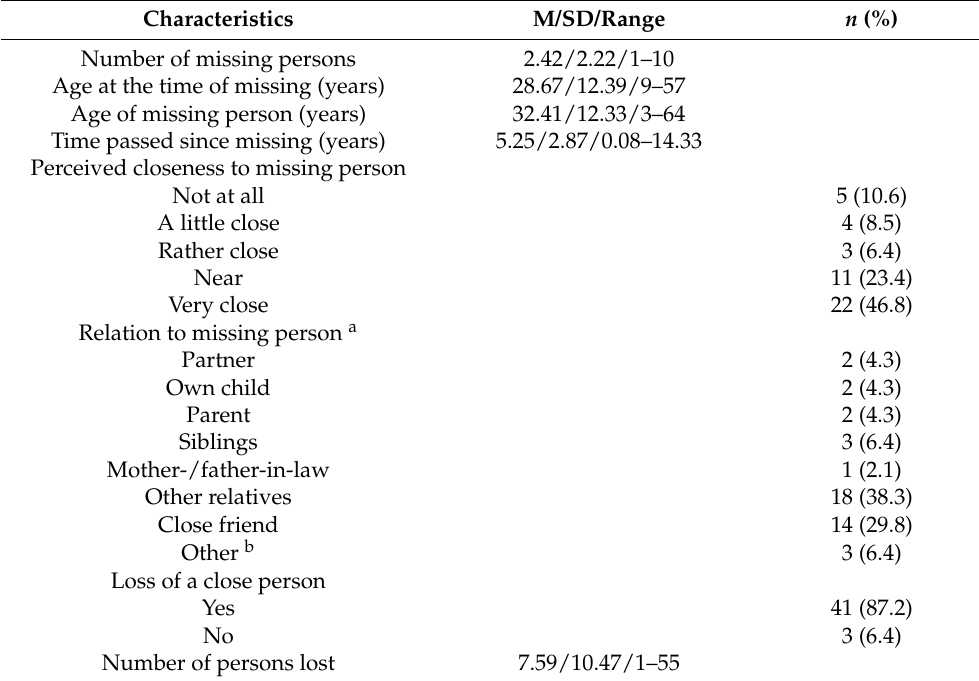
Table 3. Loss related information.